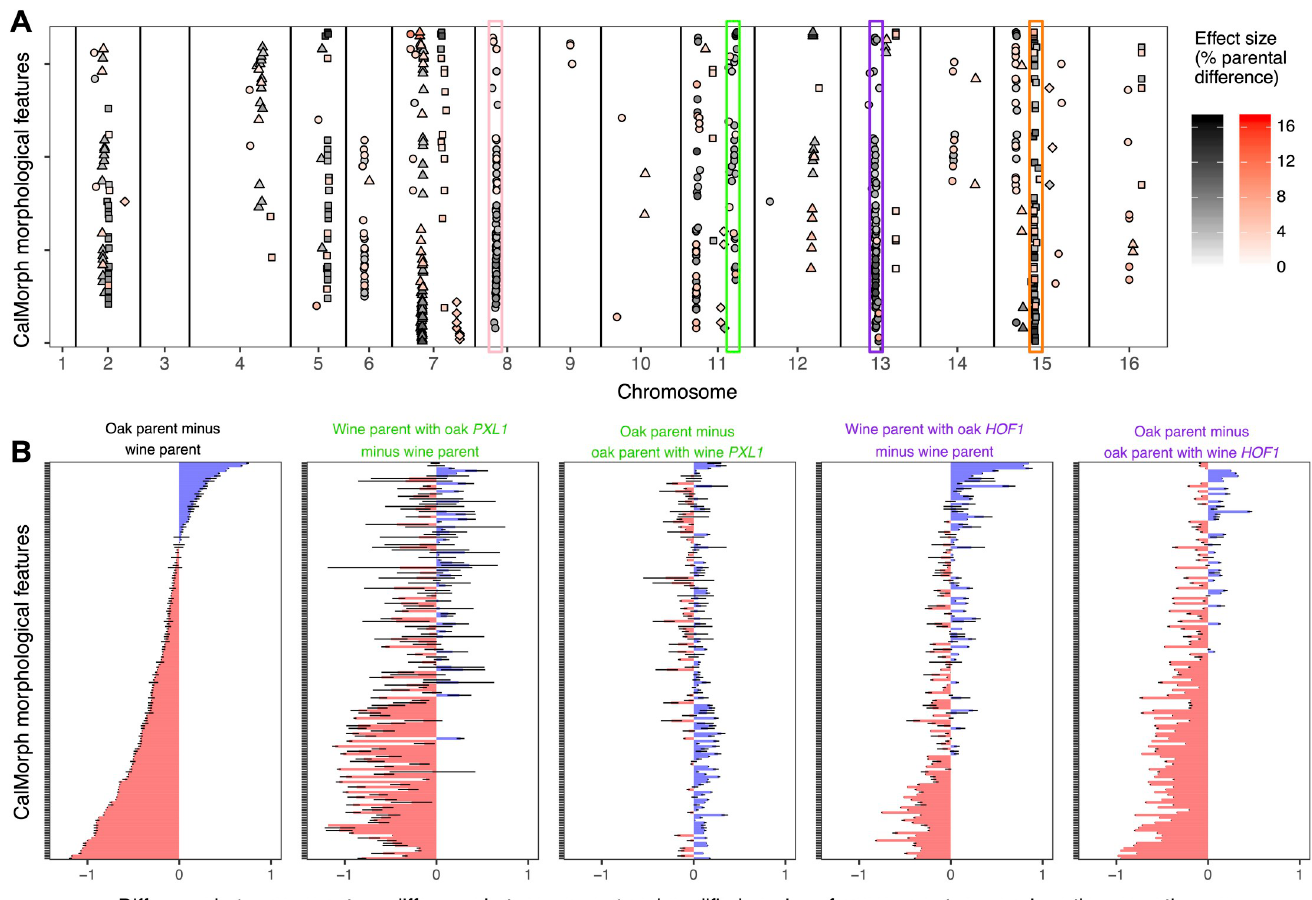
Fig 1. Pleiotropic QTL influence yeast single-cell morphology. The vertical axes in all plots represent the 155 CalMorph morphological traits for which we detect QTL. These traits are sorted, from top to bottom, based on the difference between the oak and wine parental strains. (A) Of 41 QTL that contribute to variation in single-cell morphology, 36 contribute to variation in multiple features. The horizontal axis indicates the chromosomal location of each QTL (in cM). Differently shaped points indicate separate QTL that are more than 5 cM apart on the same chromosome. The darkness of a point represents the effect size of a QTL; effect sizes range from 1.3% (lightest points) to 17.5% (darkest points) of the difference between parents. All points (red and black) represent genotype-phenotype associations detected using a per-trait genome-wide type I error rate of 5%. The points highlighted in black are significant after correcting for testing multiple phenotypes using a false-discovery rate of 5%. The QTL highlighted in pink, green, purple, and orange are very pleiotropic, contributing to 57, 30, 73, or 64 morphological features, respectively. (B) Gene-swapping experiments demonstrate that single genes contribute to multiple morphological features. The horizontal axis represents the relative phenotypic differences between the wine and oak parents (leftmost column) or one of these strains versus a derivative strain that differs in a single gene. The relative phenotypic differences between a pair of strains are calculated by scaling each trait to have a mean of 0 and standard deviation of 1 across all cells in both strains, and then subtracting the average value in one strain from that in the other. To control for variation among replicate experiments, this scaling was done independently for each replicate experiment in which both strains were imaged. Error bars represent 95% confidence intervals inferred from the replicate experiments. The two gene replacements shown, PXL1 and HOF1 , are respectively located within the QTL highlighted in green and purple in (A). When calculating the difference between strains, we always subtracted the trait values of the strain possessing more wine genes from those of the strain possessing more oak genes, such that the effects of the wine or oak gene replacements appear in the same direction on all plots. Data underlying this figure can be found at https://osf.io/b7ny5/. QTL, quantitative trait loci.